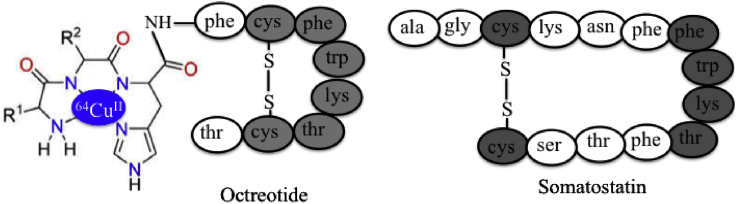
64Cu-ATCUN-Octreotide Model of Somatostatin Receptor (Targeting Tumor Cell) Providing PET ImagingR1 and R2; Y, V, N, T, G, and D amino acids.